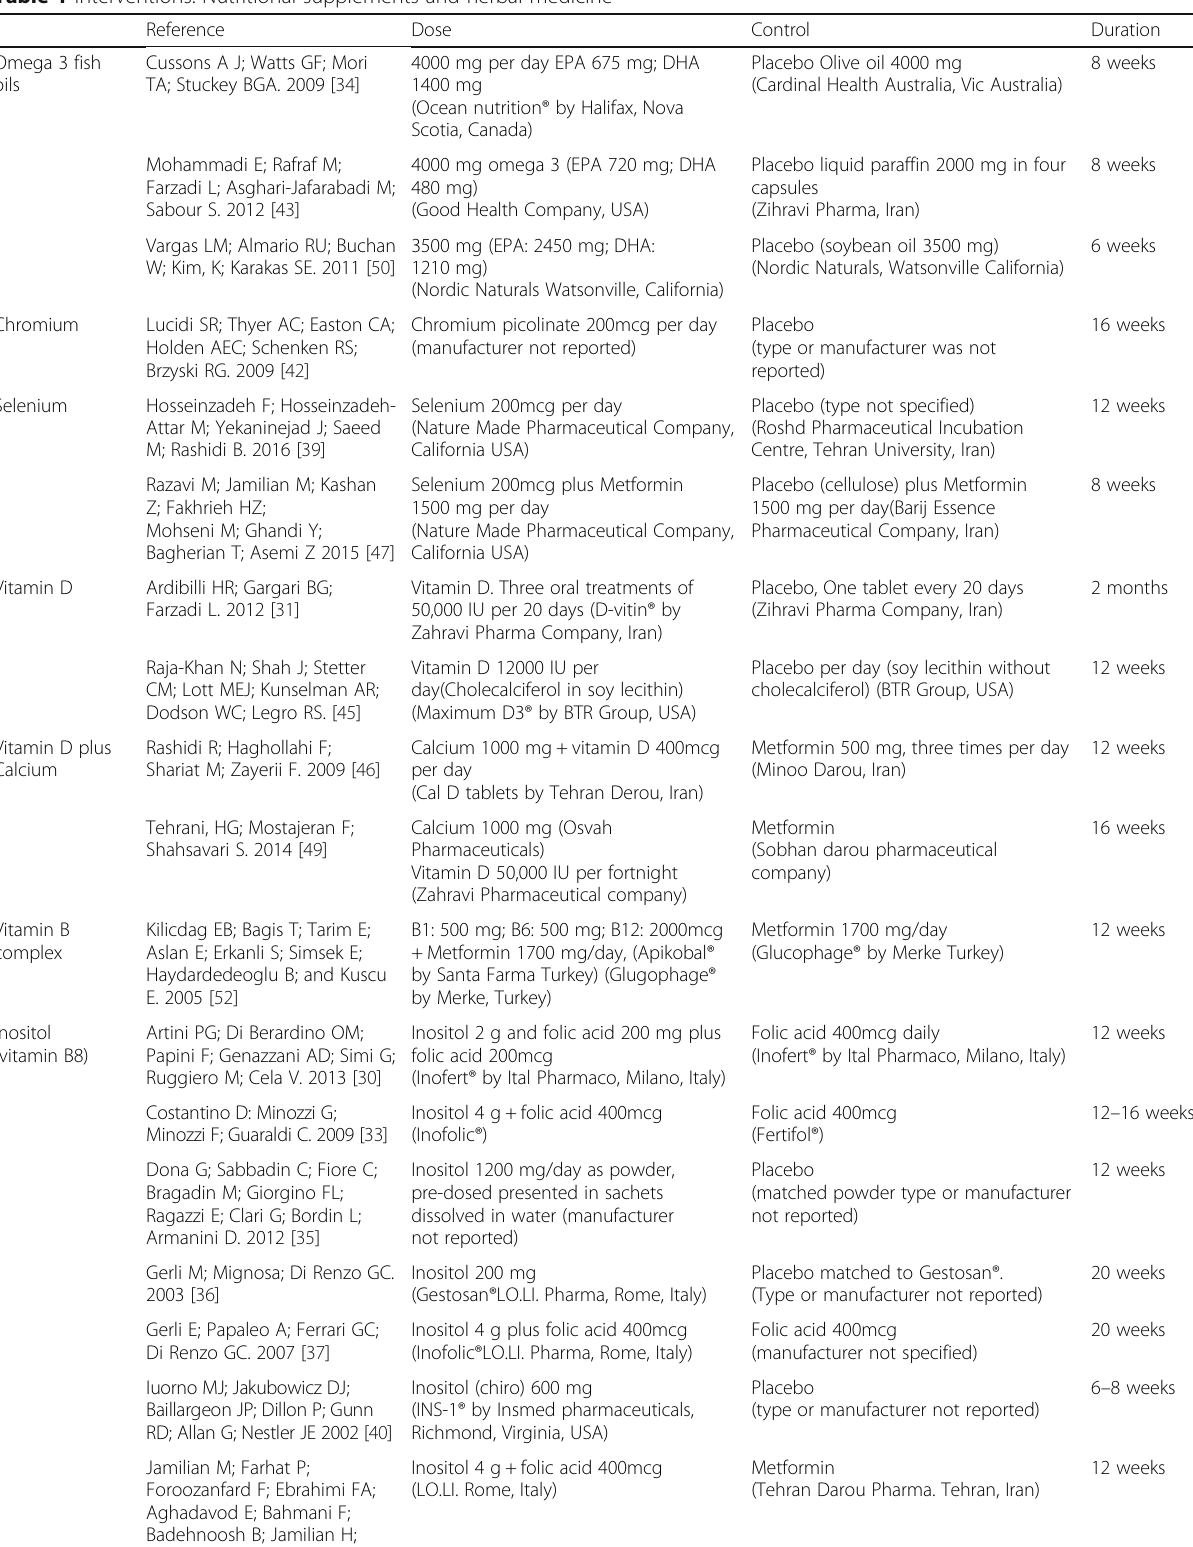
Table 1 Interventions: Nutritional supplements and herbal medicine Reference Dose Control